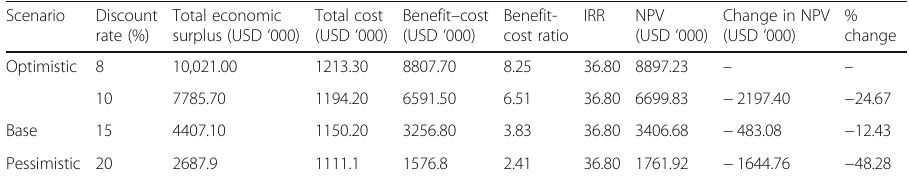
Table 4 Discount rate sensitivity analysis